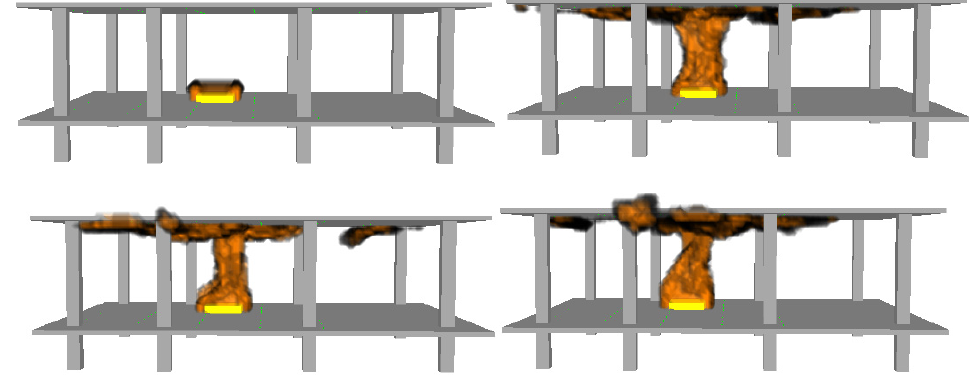
Figure 8. Flame shapes under the wind speed of 0 m/s.